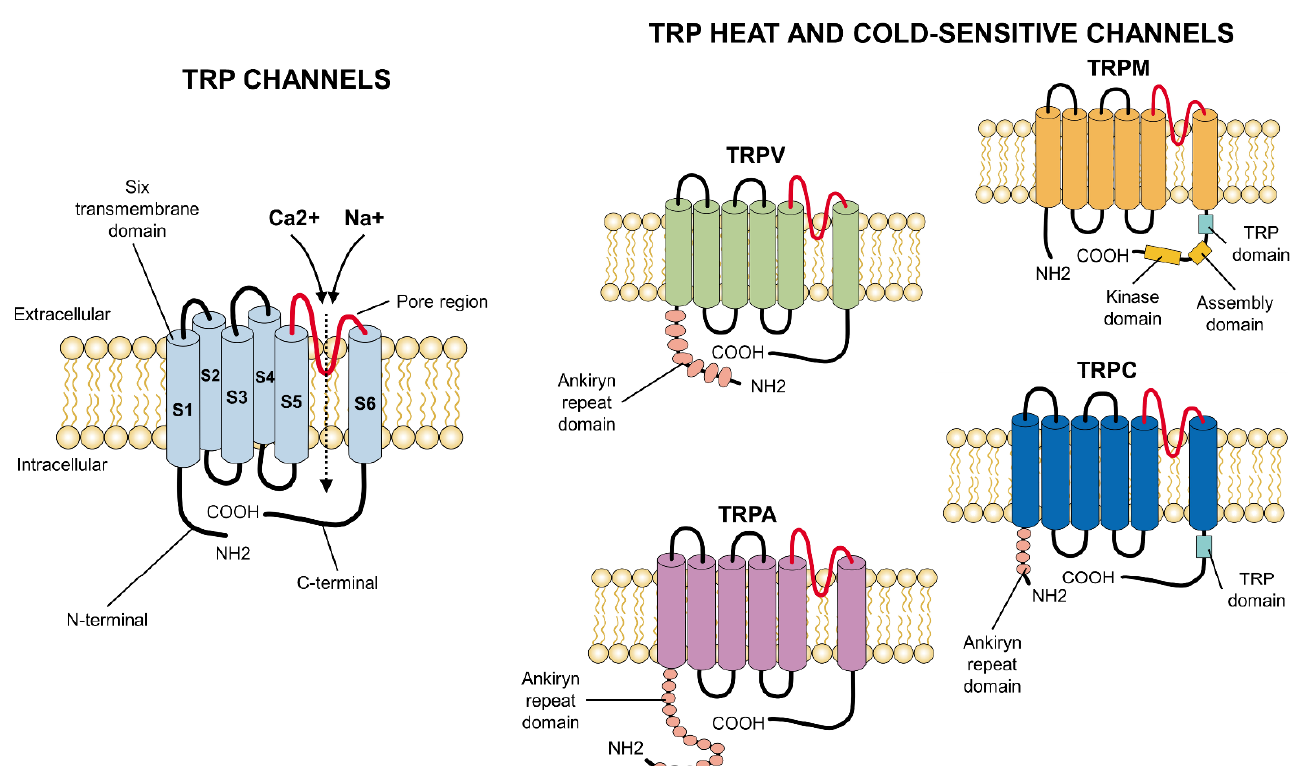
Figure 3. Primary structure of TRP ion channels. In general, all TRP channels are located in the cellular lipid bilayer and consist of six transmembrane subunits (S1–S6) with a pore region considered fundamental for the influx of cations, especially Ca 2+ or Na + . The particularities which appear at the carboxyl- (C-terminal) or amino-terminus (N-terminal) (e.g., ankyrin repeats at the latter) differ among the families of TRP channels and confer specific properties to each receptor. COOH: carboxylic acid group; NH2: amino group.